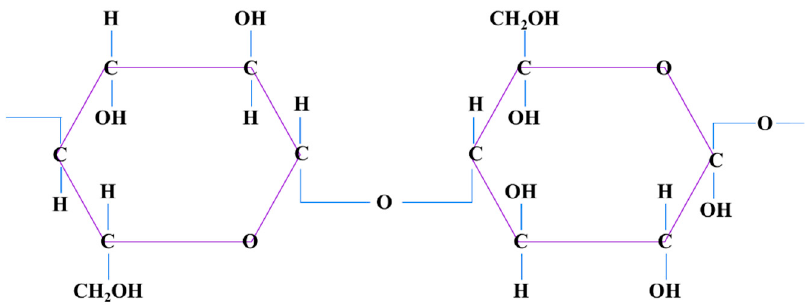
Figure 4. Cellulose structure .